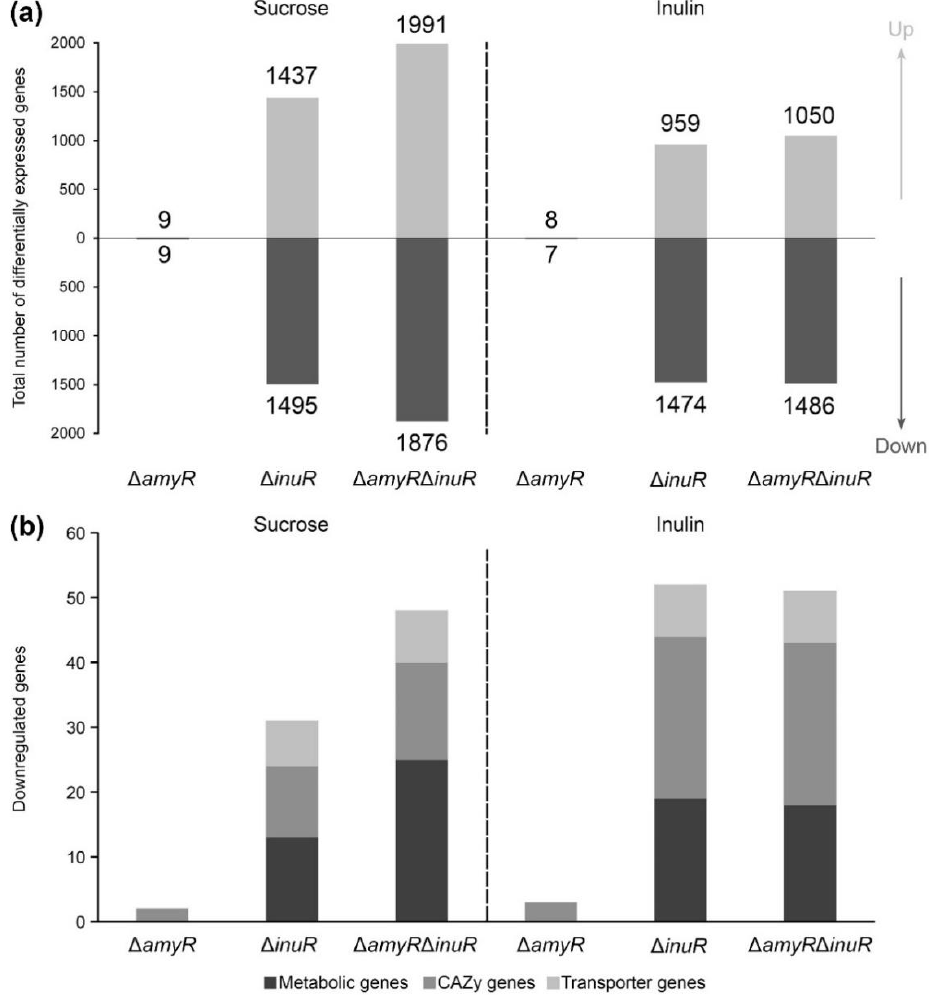
Figure 5. Differentially expressed genes (DEGs) in A. niger Δ amyR , Δ inuR and Δ amyR Δ inuR solid cultures compared to the control (CBS 138852). Samples originated from 40 h of growth on solid minimal medium containing 1% sucrose or 1% inulin as carbon source. ( a ) Total number of DEGs across the genome. Up- or downregulated genes are indicated by different tints of grey. ( b ) Downregulated plant biomass utilization-related genes. CAZy, metabolic and transporter genes are indicated by different tints of grey.